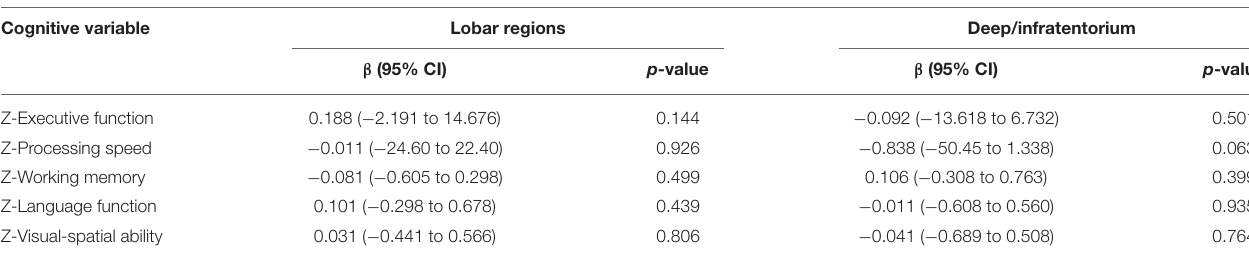
TABLE 6 | Multiple linear regression analysis in the HC group (volume of